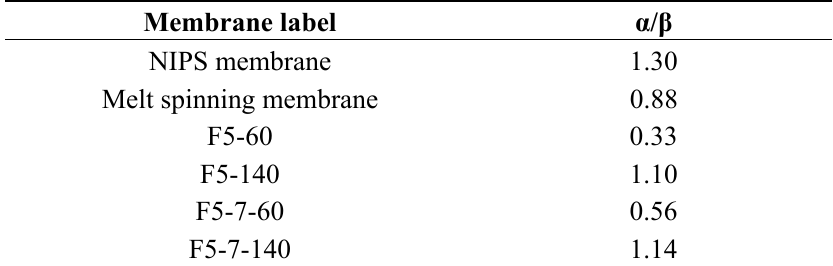
Table 2. Ratio of α phase to β phase in the outer surface layer of PVDF membranes by different preparation